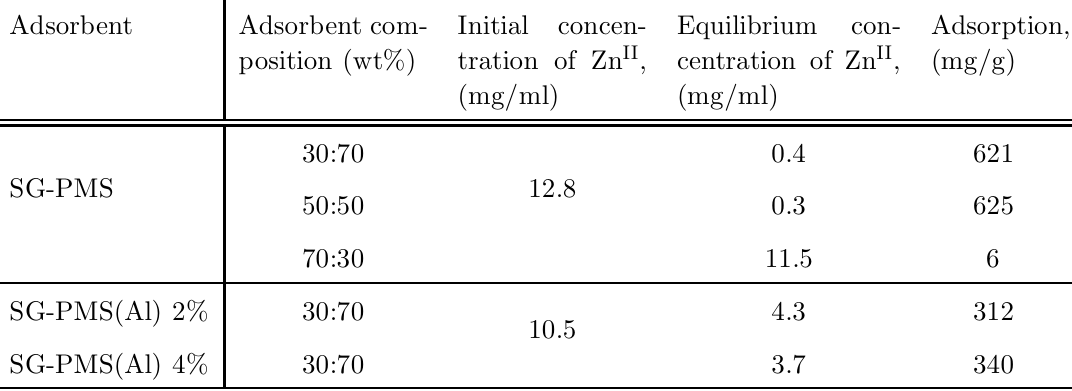
Table 3 Adsorption of Zn II on organosilica from the water-ammonia solutions. Temperature 20 o C, solid/ liquid phase ratio 1:50, contact time 2 hour, pH